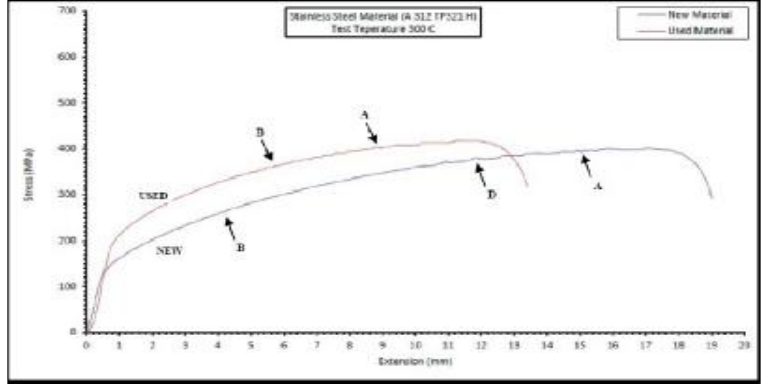
Fig. 10. Stress-strain curve at 300 o C temperature for un-used and ex-used stainless steel 321H.